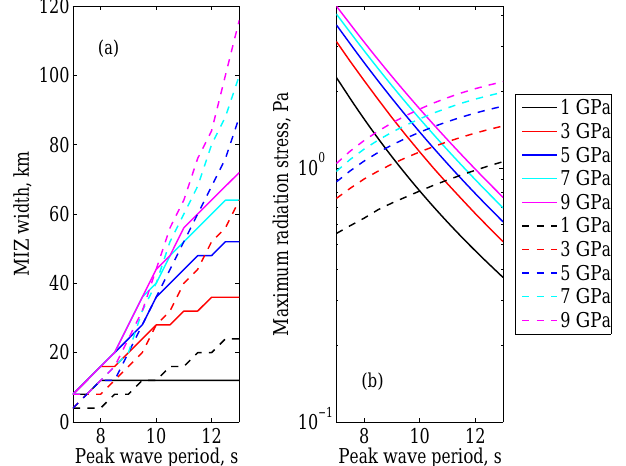
Figure 5. Variation of MIZ width (a) and maximum radiation stress (b) with peak wave period and Young’s modulus for swells of height 3m. The concentration was 0.7, the thickness was 1m, and the small-scale cohesion used was 629kPa. The WIM is not coupled to